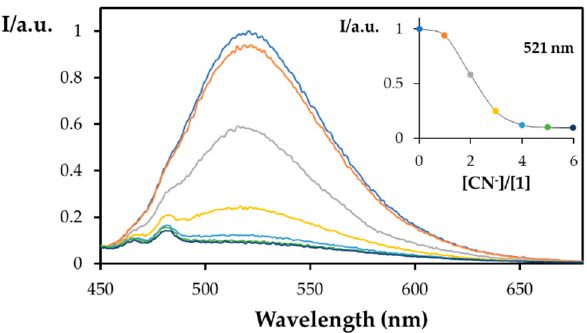
Figure 5. Spectrofluorimetric titration of dicyanovinyl derivative 1 with the addition of increasing amounts of CN − in ACN/ H 2 O (8:2). The inset represents the normalized intensity at 521 nm ([1] = 8.0 × 10 − 6